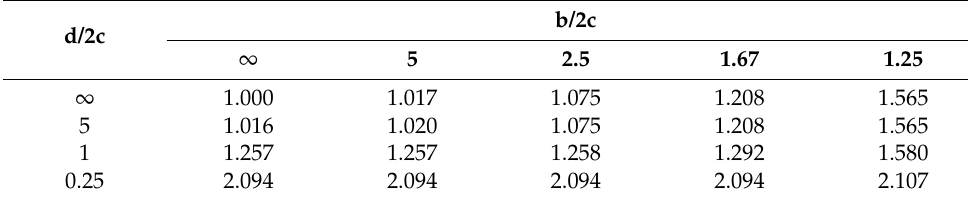
Figure 2. Model of a Cracked Rock Mass. Table 1. Values of f ( c , b , d ) .